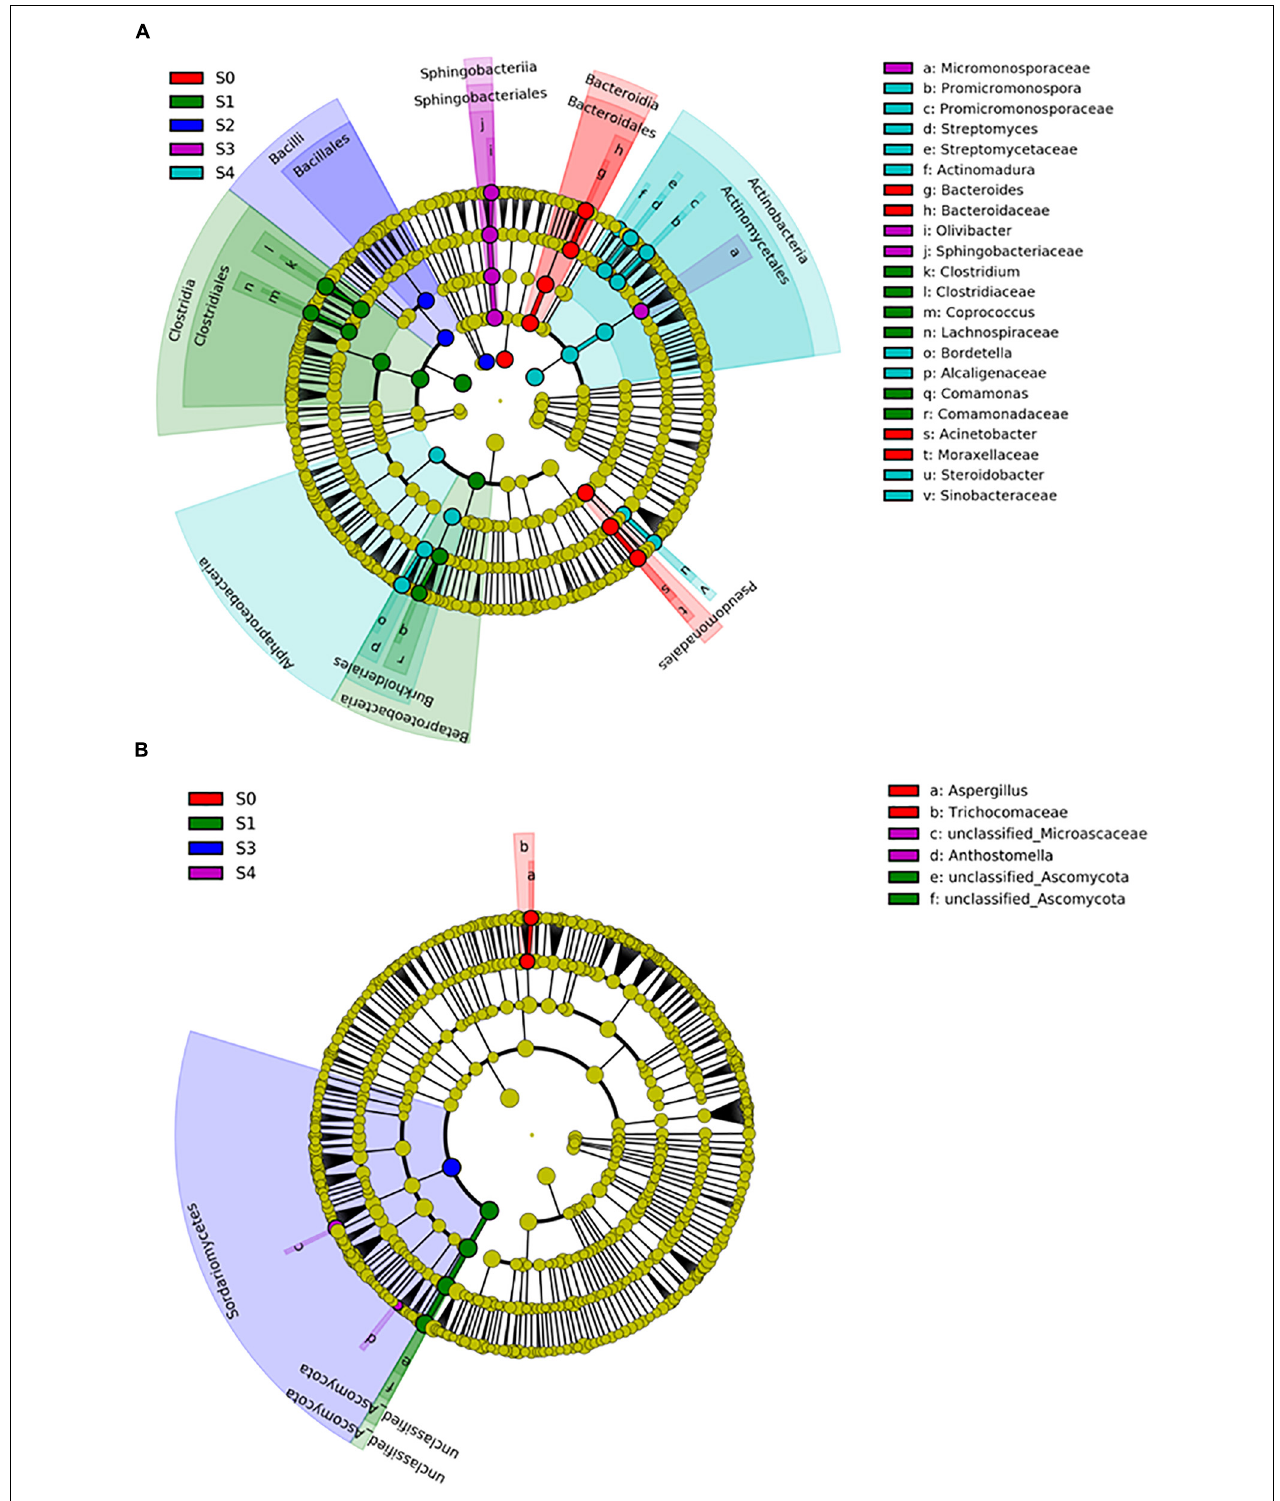
FIGURE 5 | The differential phylogenetic distribution of bacterial (A) and fungal (B) in different composting stages. The linear discriminant analysis scores of ≥ 4. Circles indicate phylogenetic levels from phylum to genus, each circle’s diameter is proportional to the taxon’s abundance. The nodes of different colors represent the microbes that play an important role in the grouping represented by the color, yellow represent non-significant.